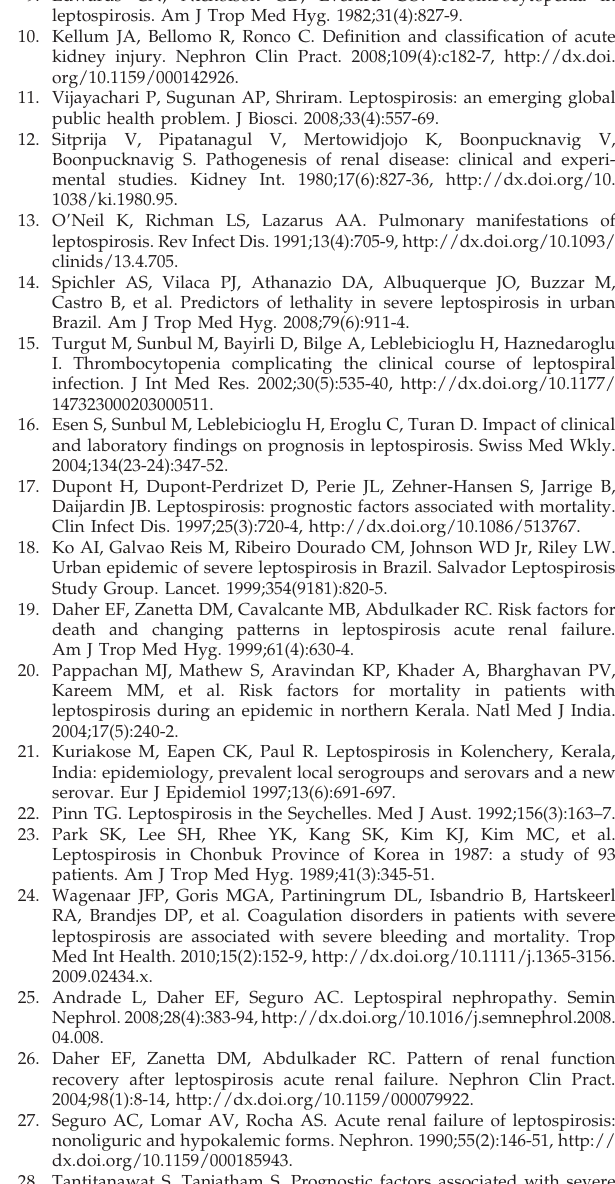
Table 5 - Independent risk factors for death in patients with